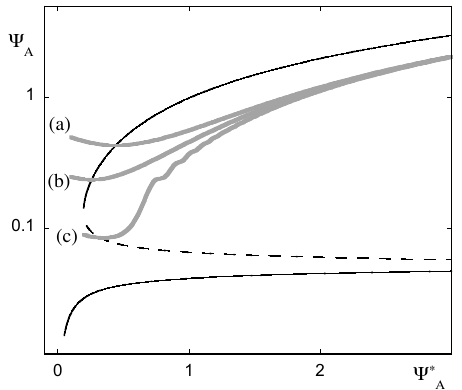
Figure 10. Time evolution of variable ψ A of model (17) in the pres- ence of a time-dependent forcing (Eq. 18). Initial conditions (a) , (b) and (c) evolve to the zonal state (upper stable branch of the bifurca- tion diagram), although in the absence of the time-dependent forc- ing the system is bound to follow the blocked circulation solution (low stable branch of the bifurcation diagram). Parameter values (cid:15) = 0 . 01 and as in Fig. 9.